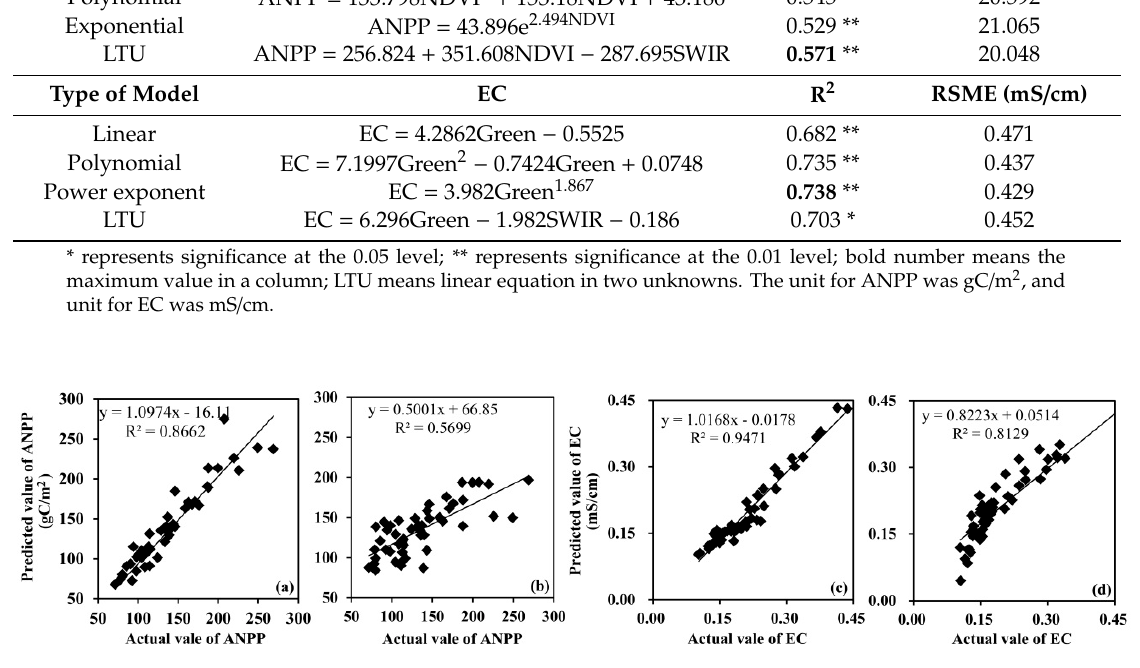
Figure 9. Relationships between predicted ANPP/EC and measured ANPP/EC of grassland. ( a ) ANPP model using RF; ( b ) ANPP model using PLSR; ( c ) EC model using RF; ( d ) EC model using PLSR.